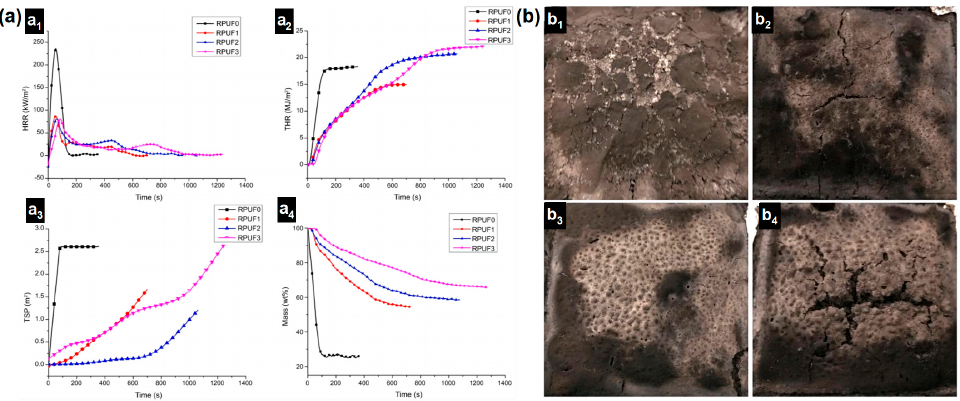
Figure 9. ( a ) Cone results of pure RPUF and coated RPUF (( a 1 ). HRR curves; ( a 2 ). THR curves; ( a 3 ). TSP curves; ( a 4 ). Mass loss curves); ( b ) digital photos of the char residue after cone tests (( b 1 ). RPUF0, ( b 2 ). RPUF1, ( b 3 ). RPUF2, ( b 4 ). RPUF3) [34].